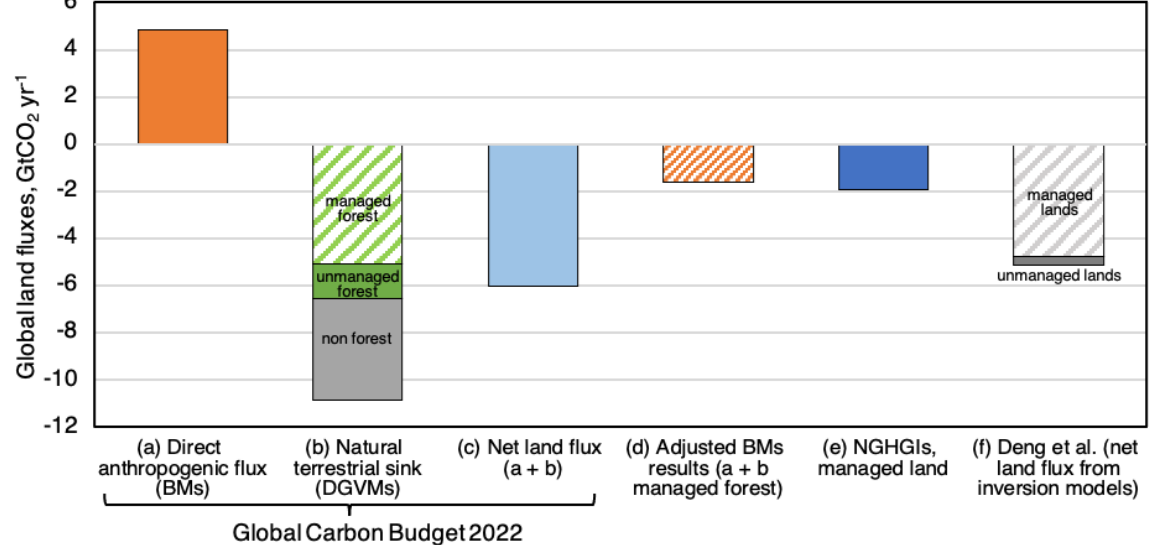
Figure 10. Components of the global land CO 2 flux from various sources: (a) flux due to direct anthropogenic effects from BMs; (b) natural terrestrial sink, reflecting the indirect anthropogenic effects on managed forest (striped area), on unmanaged forest (green area) and on non- forest land (grey area) as decomposed in our study; (c) net land-to-atmosphere flux (sum of a and total area in b ); (d) adjusted BMs’ results ( a plus striped area in b ); (e) net flux on managed land from NGHGIs (Grassi et al., 2022), updated for the DRC in this study; (f) results from inversion models for managed (dashed area) and unmanaged lands (Deng et al., 2022). Estimates in columns (a) , (b) and (c) are from Friedlingstein et al. (2022) and refer to averages for the period 2000–2020 (like columns d and e ). Estimates in column (f) refer to the period